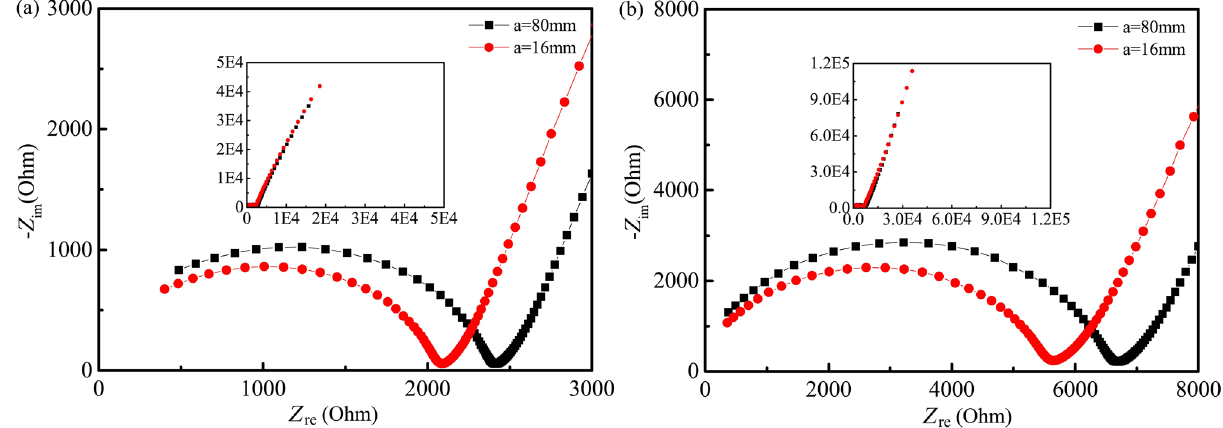
Figure 13. Nyquist plots of oven-dried samples with precast electrodes evaluated by the two-point measurement. ( a ) In the fog room curing condition. ( b ) Indoor curing condition.